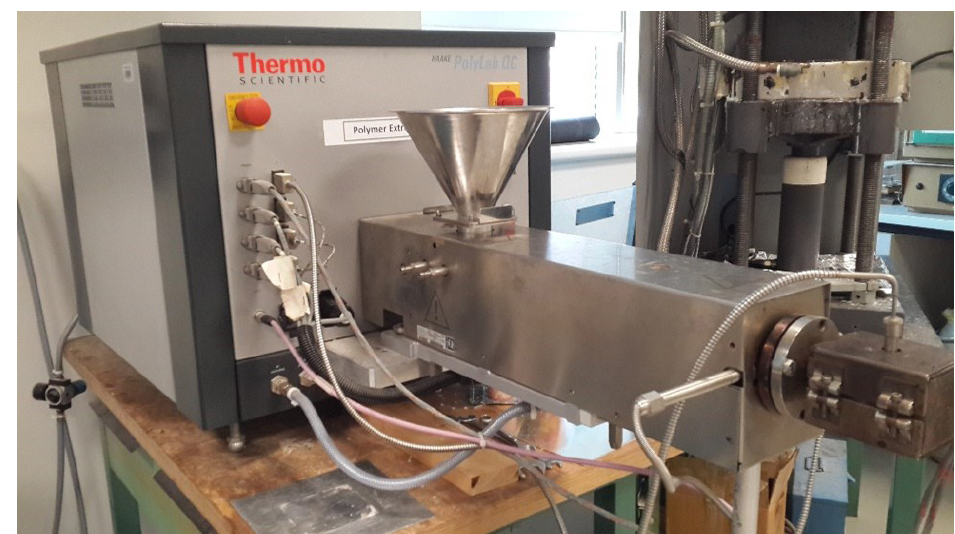
Figure 4. Extruder